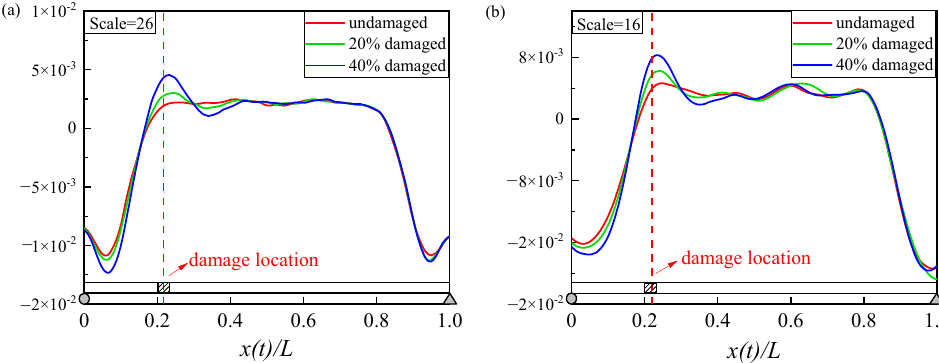
Figure 13. CWC at different speeds: ( a ) 8 m/s; ( b ) 12 m/s.